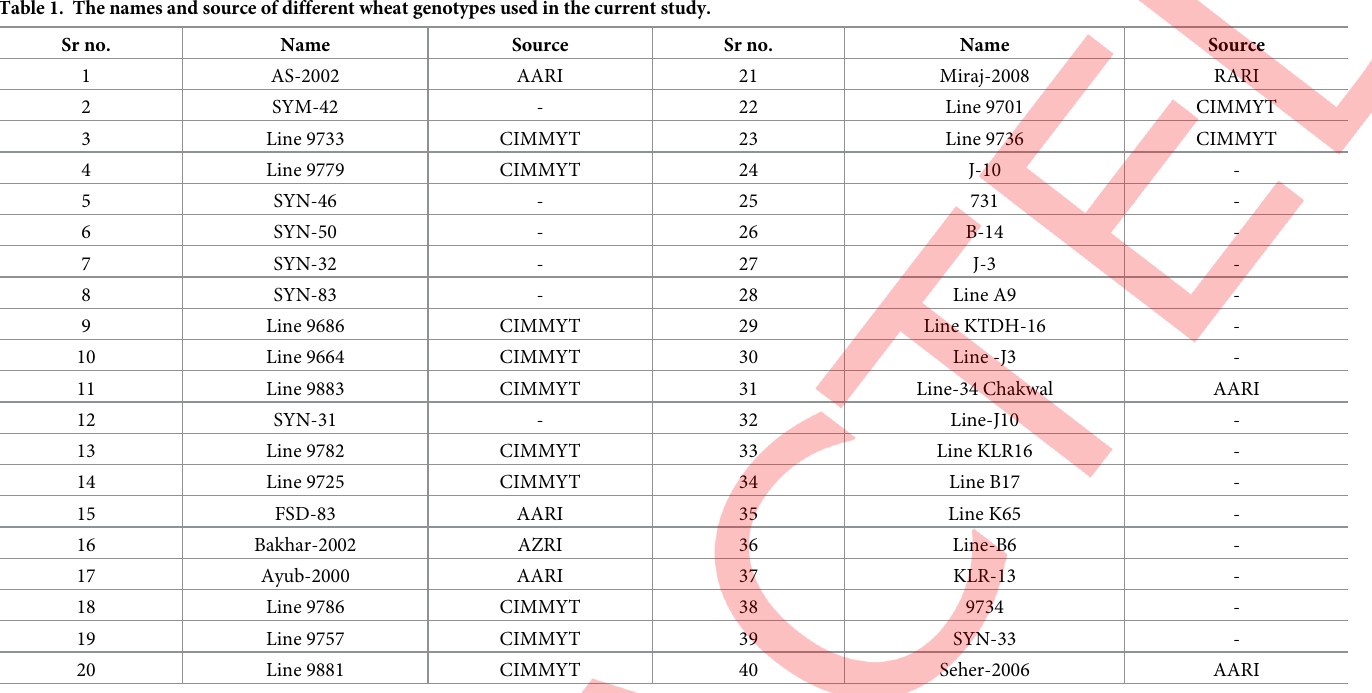
Table 1. The names and source of different wheat genotypes used in the current study. Sr